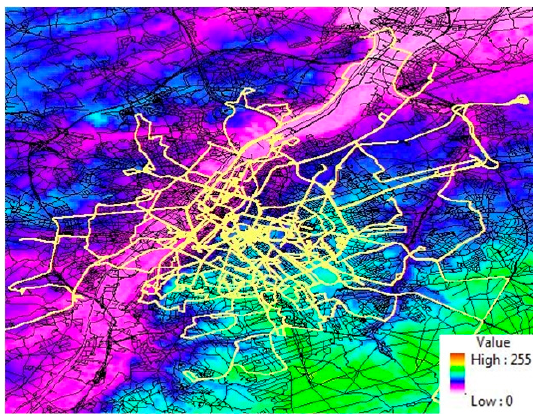
Figure 2. Part of the Dataset 2 driven trips on the road network and altitude map for the Brussels Capital Region as used in the geographic information system (GIS) software ArcGIS.